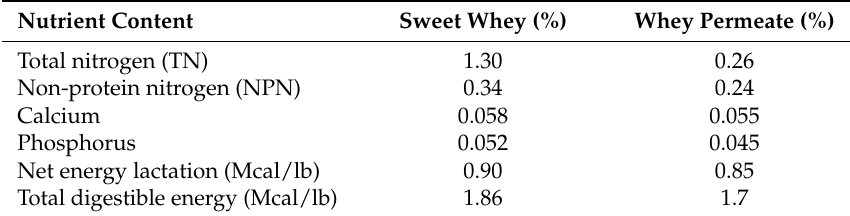
Table A1. Nutrient content of cheese whey types (dry matter